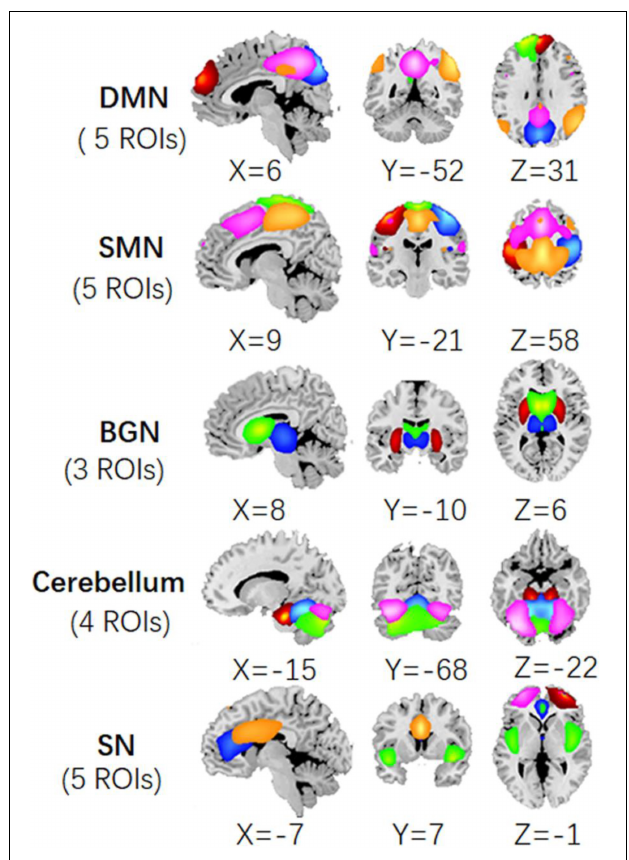
FIGURE 2 | The ROIs extracted from the ICA processing of fMRI data, including precuneus, angular, PCC, frontal_sup_medial areas in DMN; bilateral post_central, pre_central, paracentral_lobule, and SMA in SMN; thalamus, putamen, and caudate in BGN; frontal_mid, ACC, MCC, and insula in SN; and cerebellum